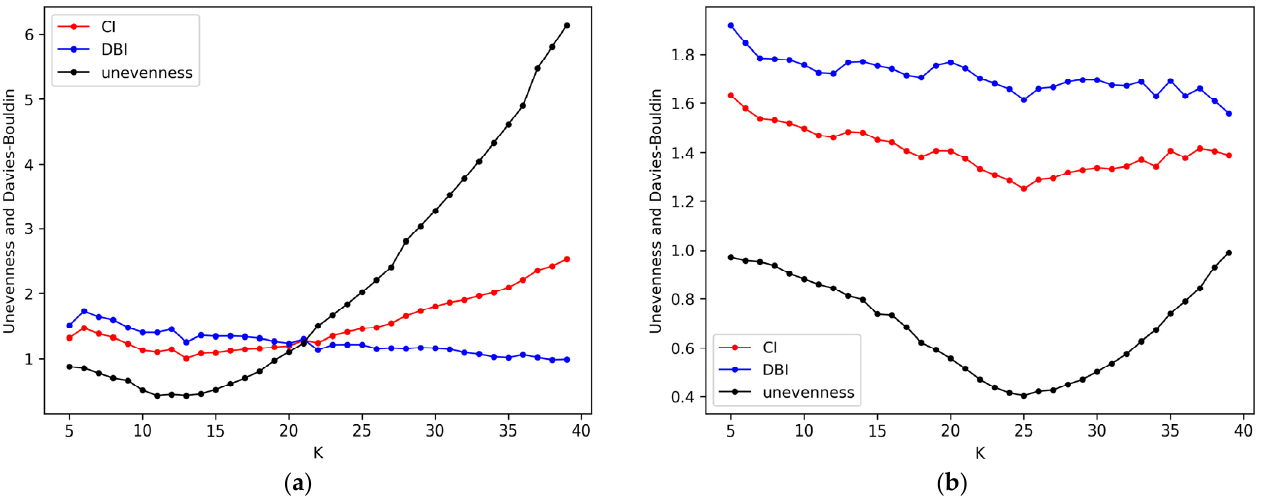
Figure 4. Determination of the suitable number of groups: ( a ) Determining the suitable K for school_1; ( b ) Determining the suitable K for school_2.